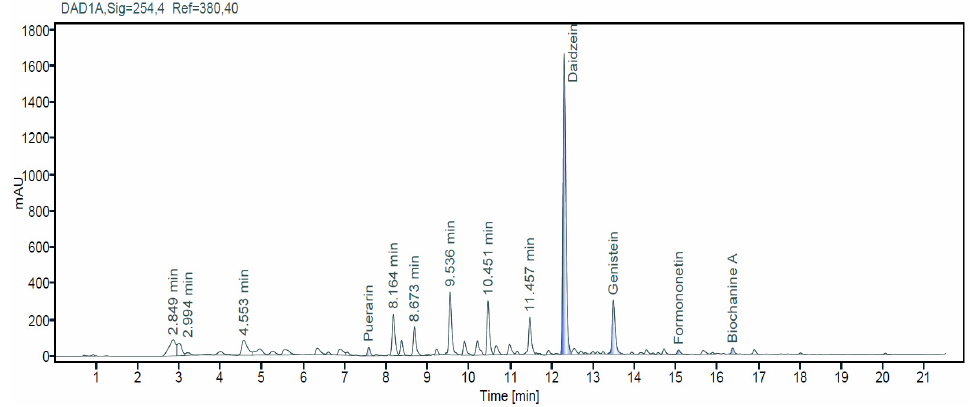
Figure 2. Representative HPLC-UV chromatographic profile for NADES extracts of kudzu roots.